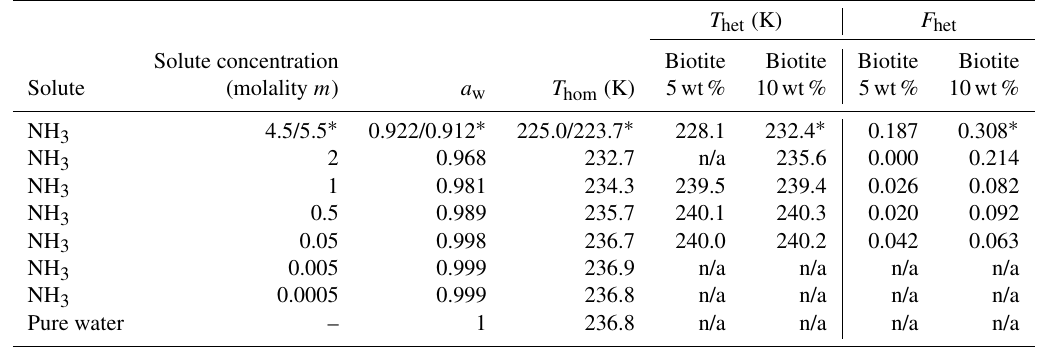
Table 2. Summary of the freezing experiments with emulsified aqueous solution droplets containing biotite (5wt% and 10wt%). Note that the absolute uncertainty in F het may be up to ± 0.1. Only F het above this threshold are clear evidence of heterogeneous